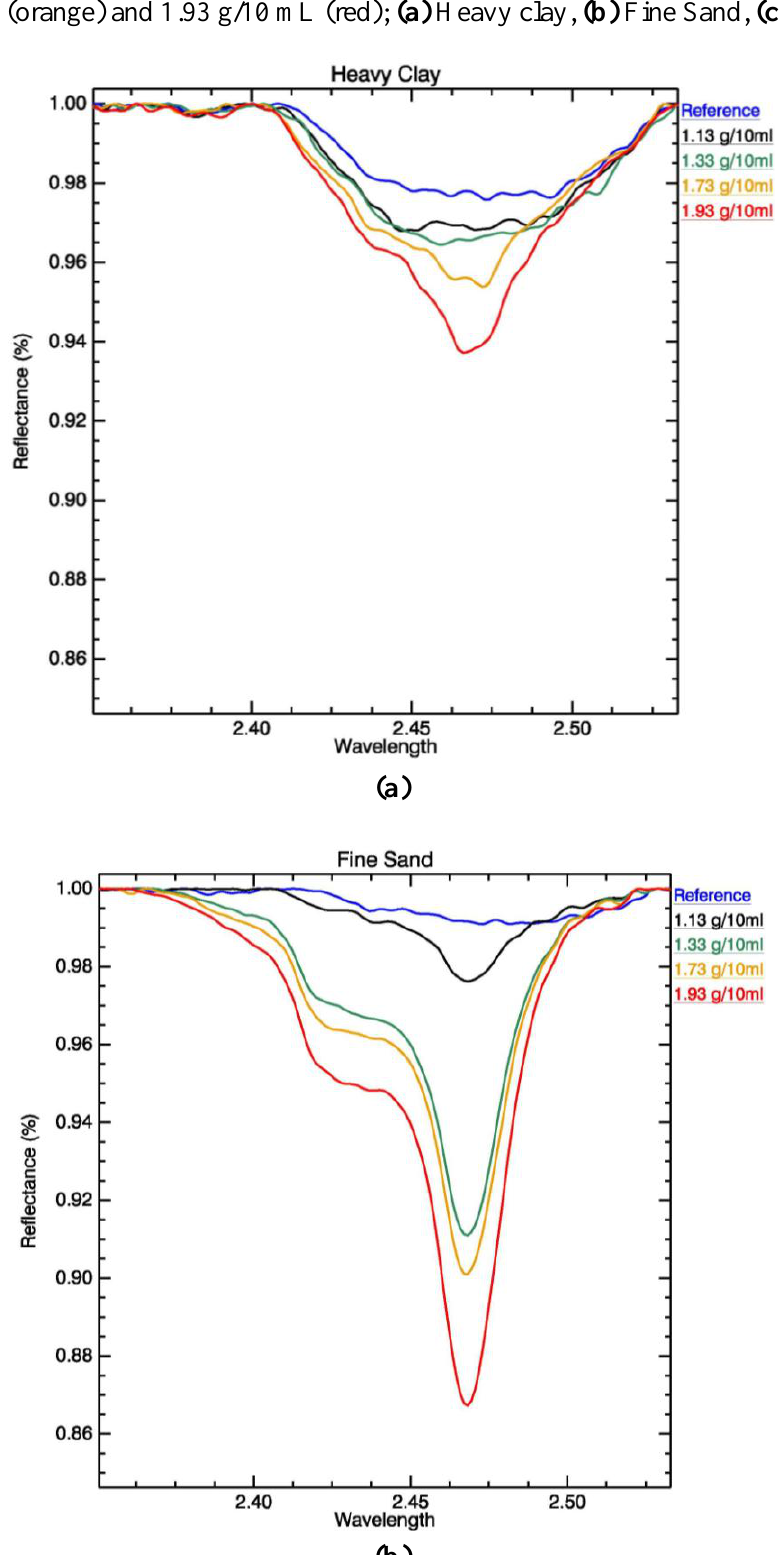
Figure 3. Change in absorption at 2,450–2,470 nm with change in K concentration. Each spectrum is an average of 10 measurements. The blue lines belong to soils with no added fertilizer and used as a reference. The deeper absorption features belong to samples with addition of K fertilizer in concentrations 1.13 g/10 mL (black), 1.33 g/10 mL